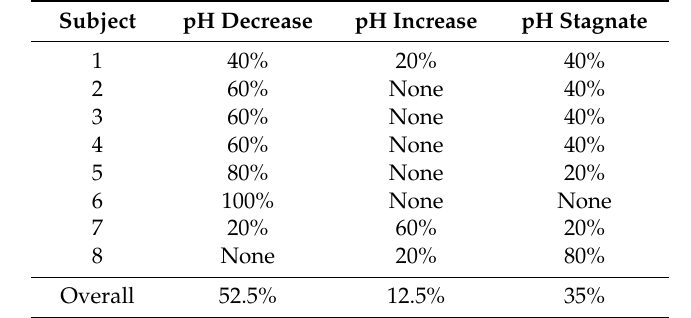
Figure 5. pH values (mean ± SD) of di ff erent hair regions summarized via five hair measurements per subject ( a ) and the pH values (mean ± SE) for all subjects in the di ff erent hair regions ( b ). “*” represents significant di ff erence p < 0.05 between the groups. Table 1. All hair pH measurement results itemized to pH decreasing from hair sheath to external hair shaft (pH di ff erence ≥ − 0.5), increasing from hair sheath to external hair shaft (pH di ff erence ≥ + 0.1), and pH stagnation (remaining